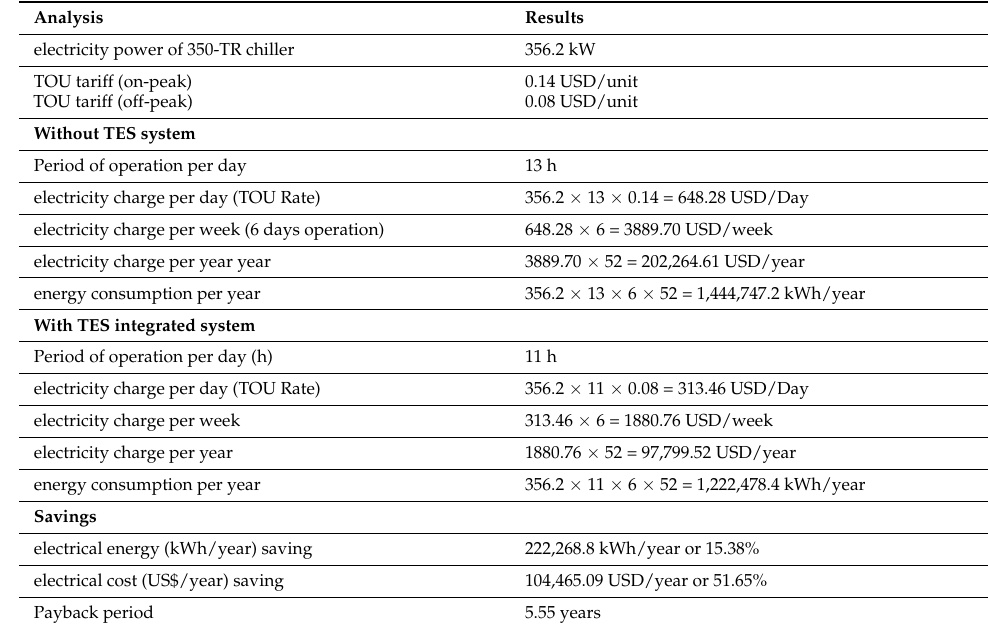
Figure 8. Temperature profiles during discharging and charging stages when chilled water was 4 ° C. Table 5. Economic analysis